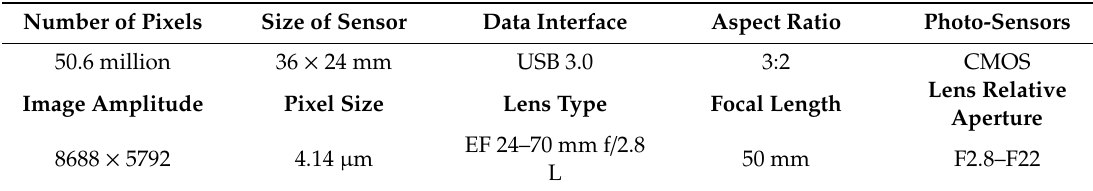
Table 1. Parametric table of camera and lens.